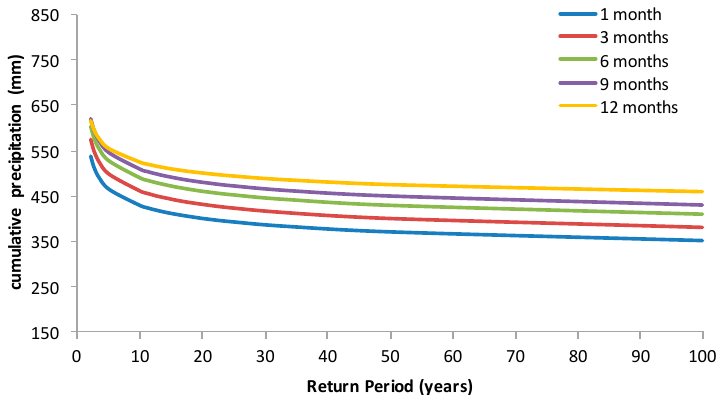
Figure 7. Regionalized Severity-Duration-Frequency (SDF) curves for semi-arid climate influence in Minas Gerais The regionalized SDF curves were tested on its precision by the error computation, comparing the regionalized SDF curves with the 9 stations situated in the semi-arid area of Minas Gerais. The